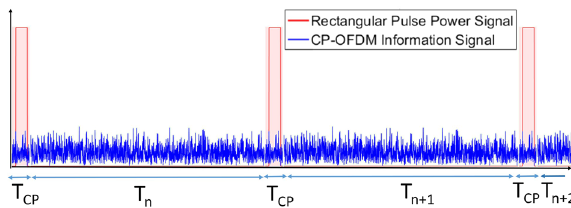
Fig. 2 Proposed waveform by superposing WPT and WIT signals in a synchronized